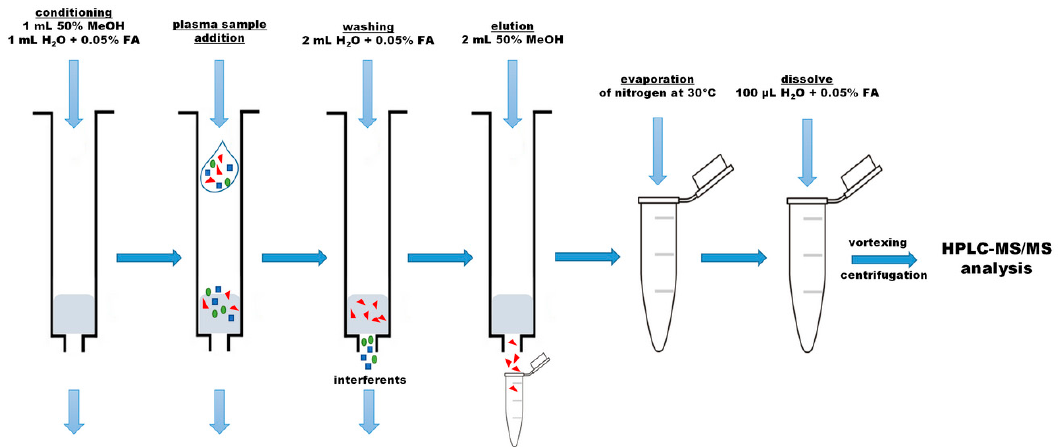
Figure 1. Schema of the plasma samples preparation.